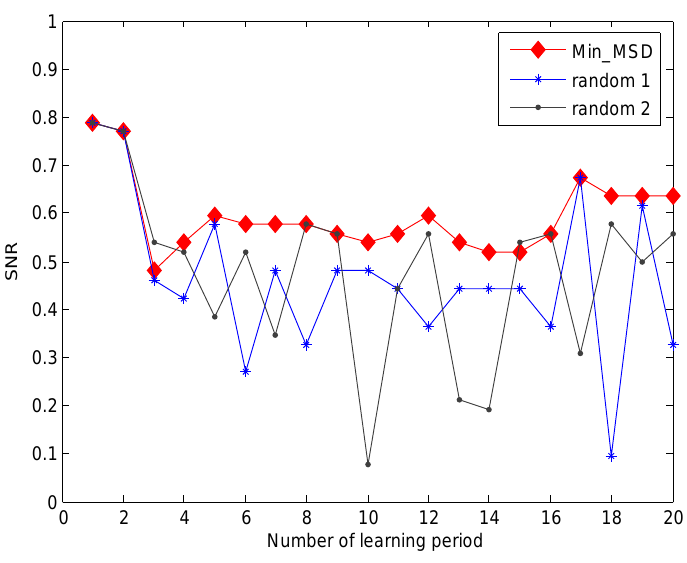
Figure 4. Effect of cluster head selection using the Min − MSD and random approaches on SNR.